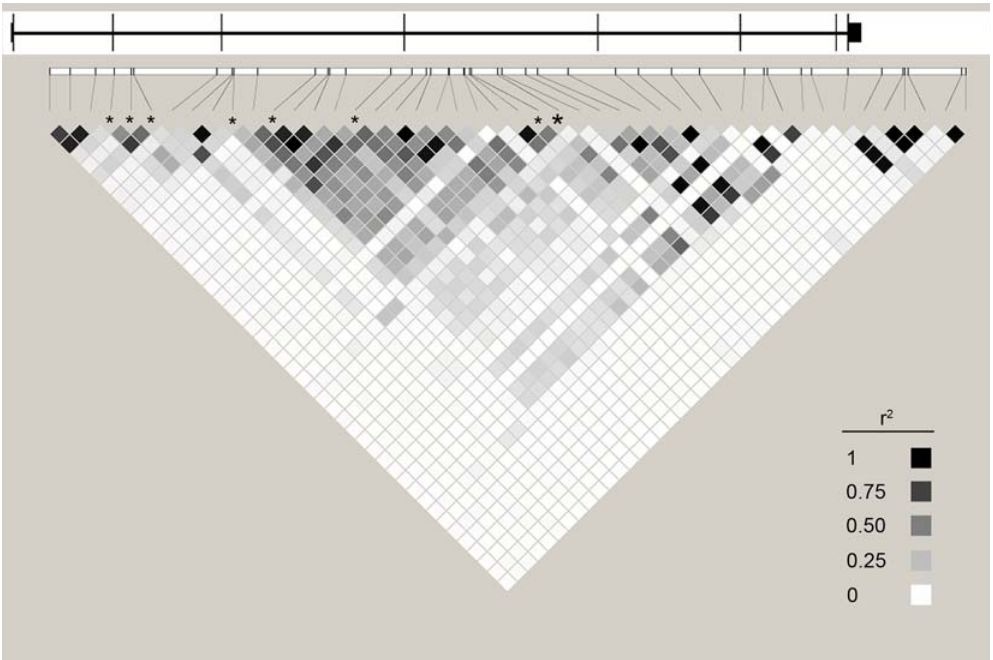
Figure 2. Schematic illustration of the estrogen receptor gene ( ESR1 ) and its linkage disequilibrium structure. The line in the top part of the figure illustrates the ESR1 gene with the exons marked with horizontal lines. The lower part of the figure shows the positions of the single nucleotide polymorphisms (SNPs) in ESR1 genotyped in the ULSAM cohort with pair-wise linkage disequilibrium (r 2 ) values. The SNPs with nominal p- values , 0.05 in the ULSAM cohort are marked with stars, and the SNP rs2179922 located in intron 4 of ESR1 with p=0.0056 in the PIVUS cohort is marked by a large star.